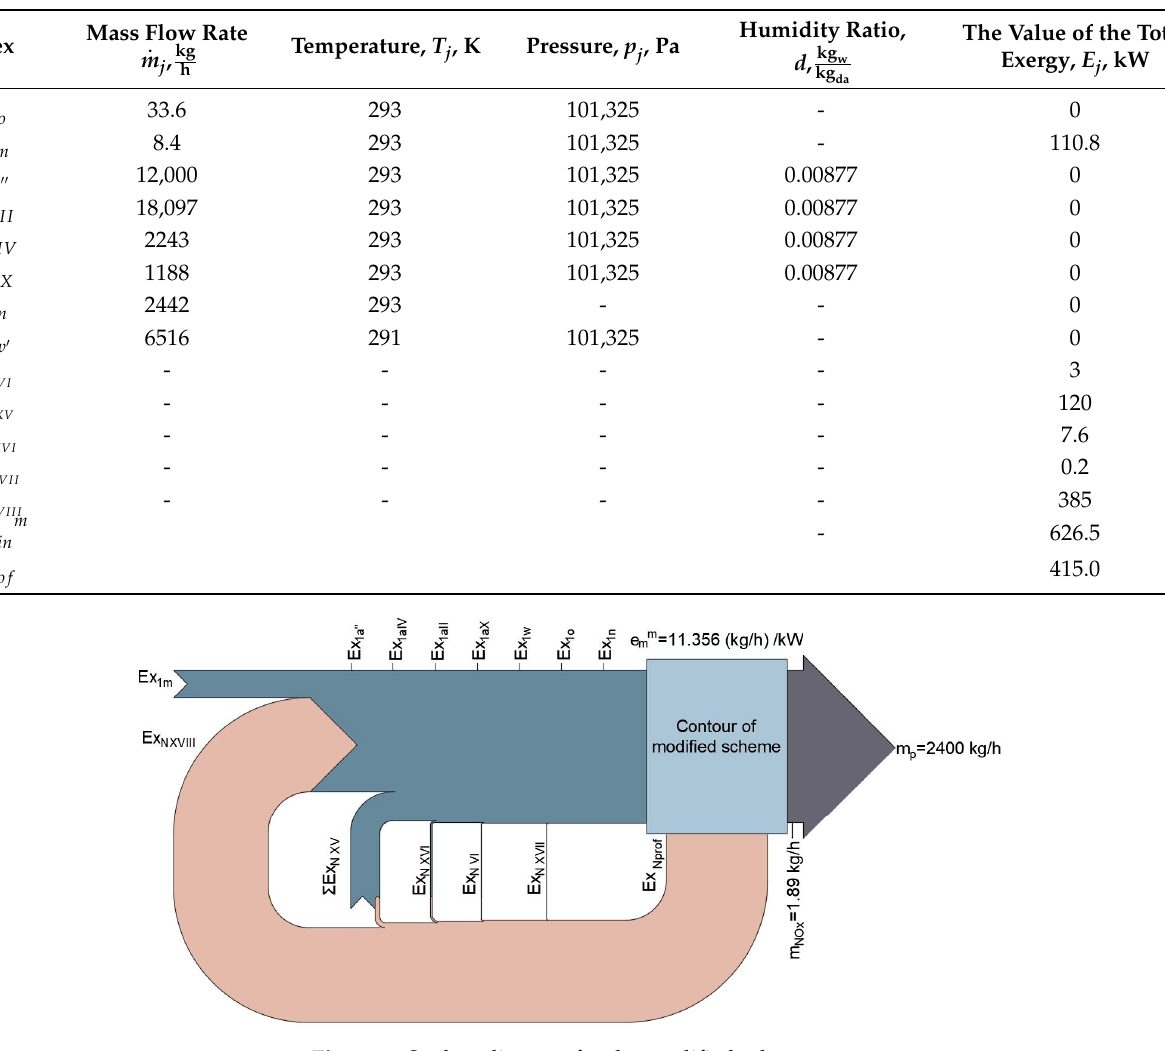
Figure 6. Sankey diagram for the modified scheme. The specific exergy expenditure to produce a product in a modified system is found by the equation: